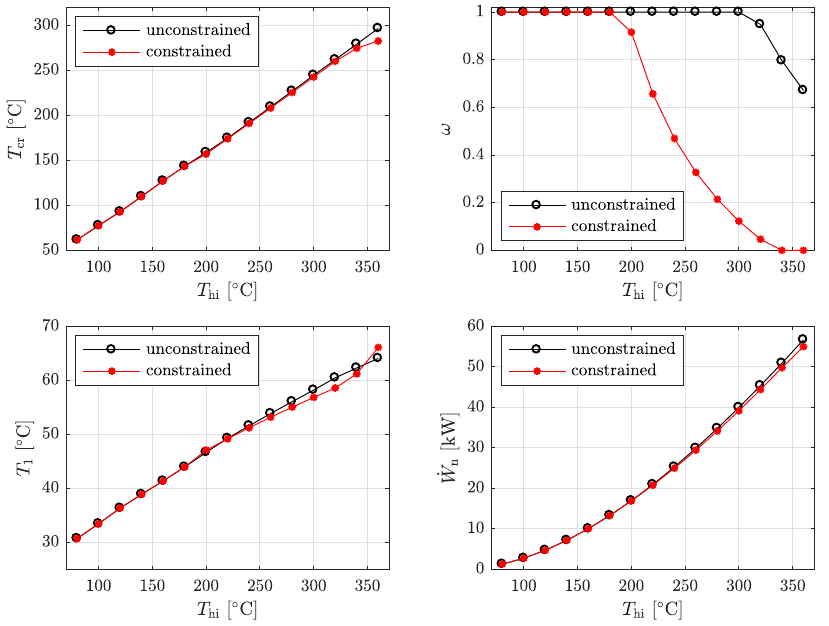
Figure 3. Optimal fluid and cycle parameters for different heat-source temperatures for an unconstrained ( p 1 ≥ 5 kPa) and constrained ( p 1 ≥ 100 kPa) condensation pressure with ω included as an optimisation